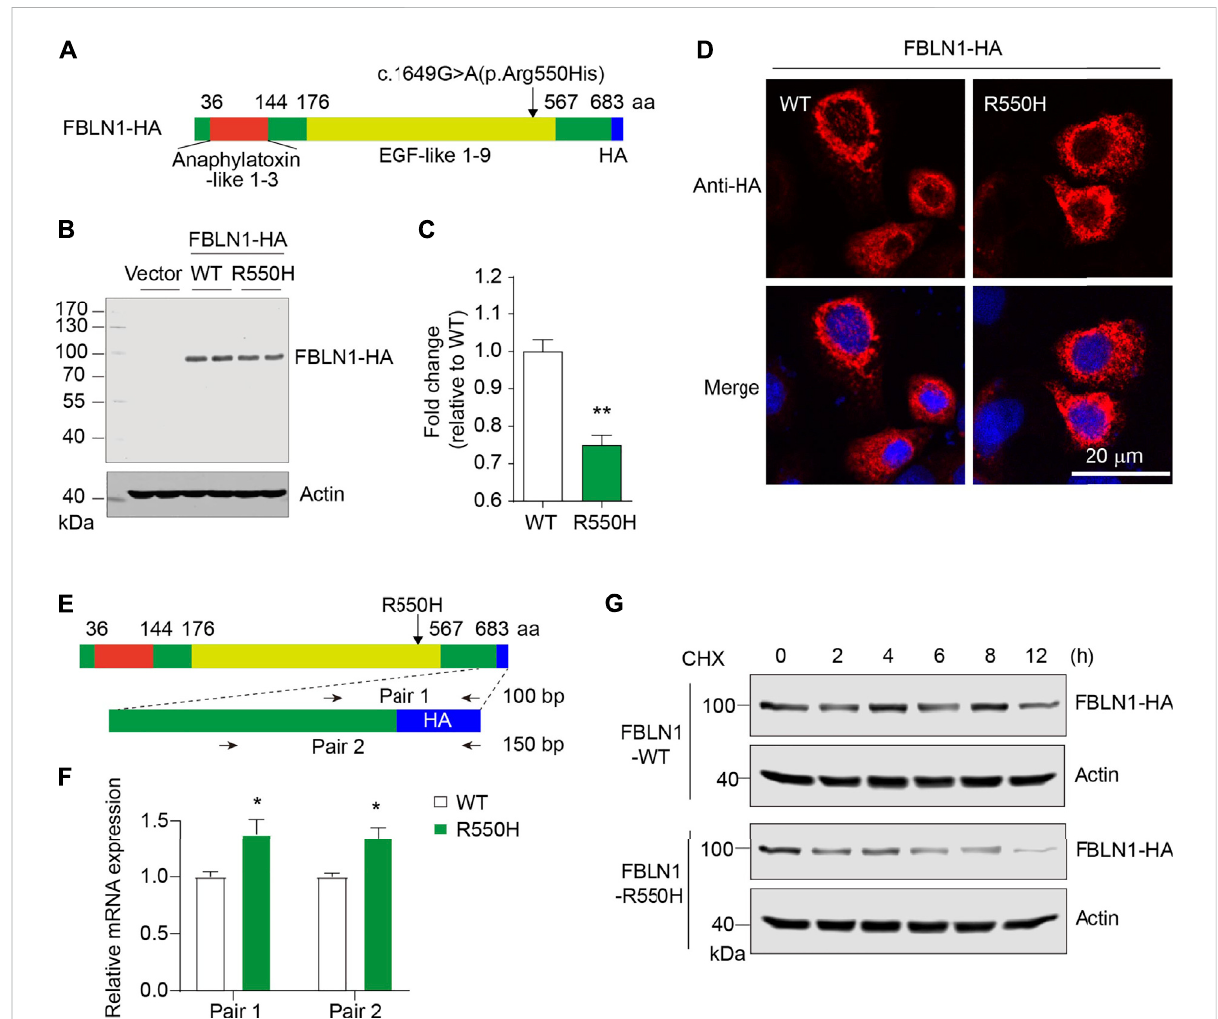
FIGURE 3 Defective expression of FBLN1 mutant is caused by impaired protein stability. (A) Schematic illustration of molecular structure of HA-tagged FBLN1.Missensemutationsitewasshown. (B) RepresentativeimmunoblotsofexogenousFBLN1expressioninHeLacellsusinganti-HAantibody. (C) Quanti fi cation of B ( n = 3 – 4 per group). ** p < 0.01. (D) Representative immuno fl uorescence staining of FBLN1-HA in transfected HeLa cells. (E) Primer design for quantitative real-time PCR at C-terminus of FBLN1 construct. (F) Quantitative real-time PCR results suggesting mutant FBLN1-transfectedcellsshowed moremRNA expression. n =3pergroup. * p < 0.05. (G) TransfectedHeLacellsweretreatedwith proteintranslation inhibitor cycloheximide (CHX, 50 μ g/ml) and subjected to